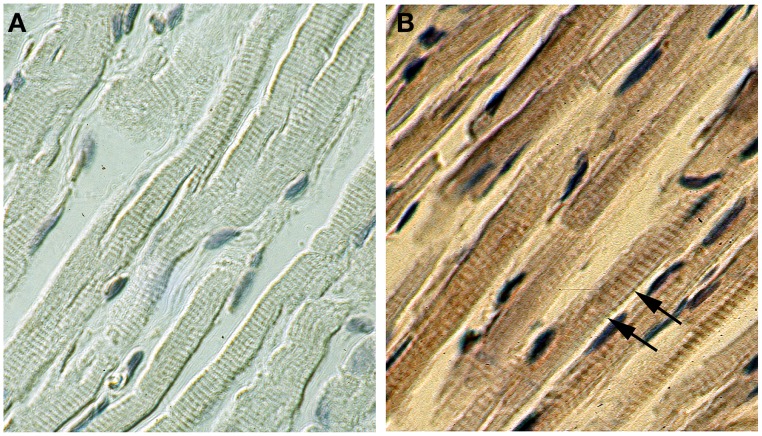
Expression of FL-MMP-2 in transgenic hearts. Immunohistochemical staining for the c-myc epitope tag of the FL-MMP-2 transgenic using peroxidase stain for wild type (A) and transgenic (B) ventricular sections (400× original magnification). The staining in a regular banding pattern (indicated by arrows in B) is consistent with a sarcomeric localization. No staining was evident in wild type.